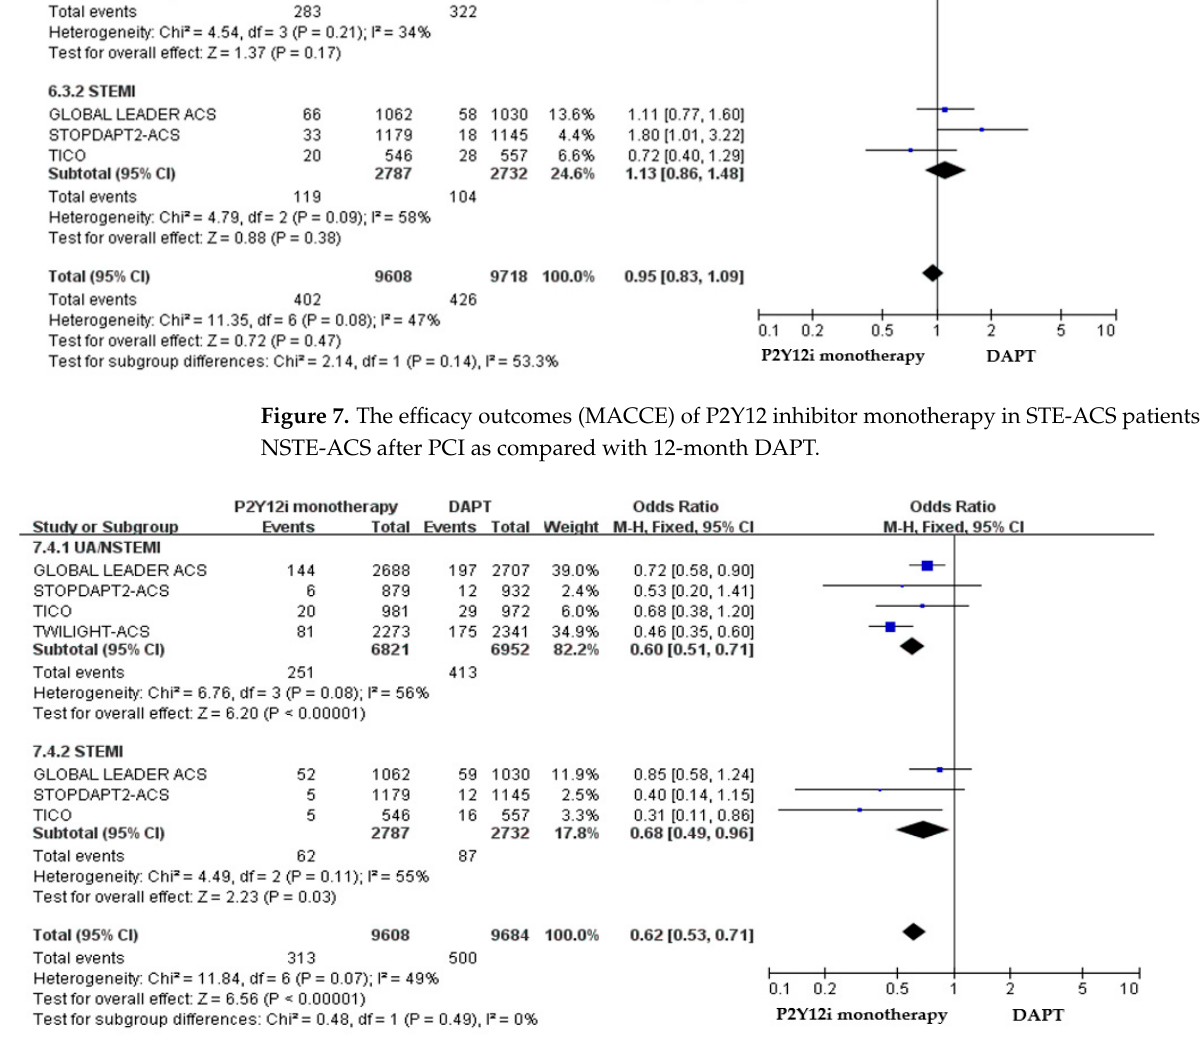
Figure 8. The safety outcomes (major or minor bleeding events) of P2Y12 inhibitor monotherapy as compared with 12-month DAPT in patients with STE-ACS and NSTE-ACS patients after PCI.